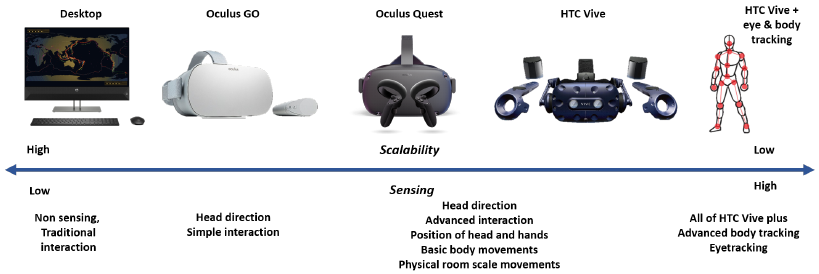
Figure 2. SENSATIUM, the SENsingScAlability Trade-off contInuUM (modified from (Klippel et al., 2020)) (see Section 2.1).